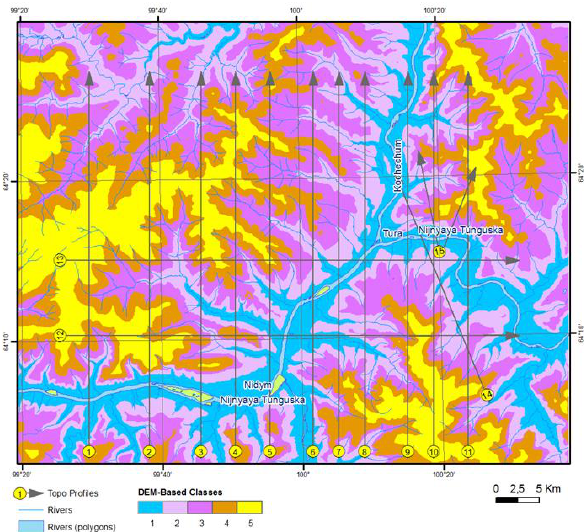
Figure 3. DEM-based classes of morphometric relief parameters for the test site: